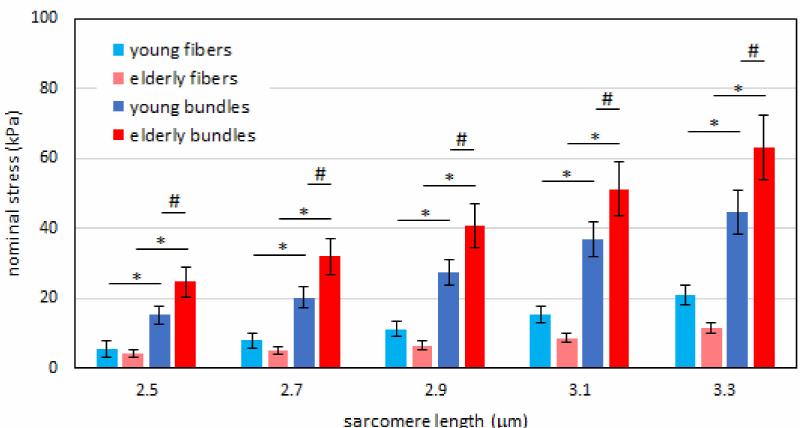
Figure 2. Histogram of the passive tension in the fibers (pale color) and in the bundles (dark color) at di ff erent sarcomere lengths for the young (blue) and elderly (red) subjects. Post-hoc comparisons of ANOVA are shown. * p < 0.05, statistical di ff erence between fibers and bundles in the same age group. # p < 0.05, statistical di ff erence of bundles between age groups. Data are shown as mean value +/ - SEM. Note that the di ff erence between fibers of young and elderly subjects does not reach statistical significance at any sarcomere